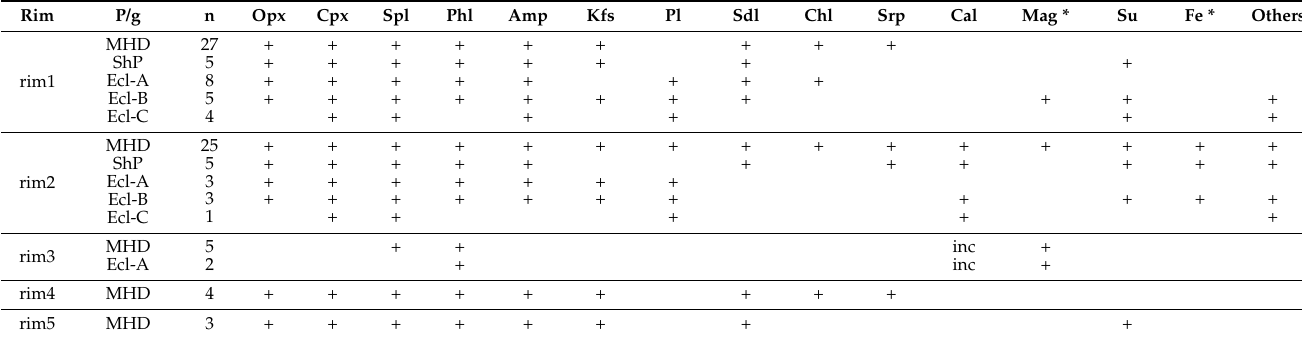
Table 1. Main and accessory minerals in the different types of rims on mantle xenolith